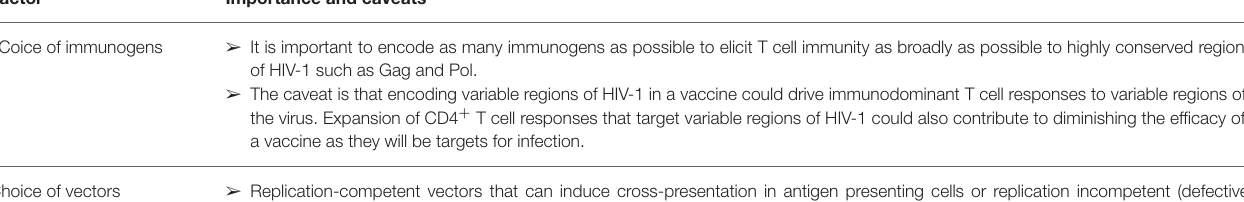
TABLE 1 | Future challenges for the development of a T cell-mediated vaccine.